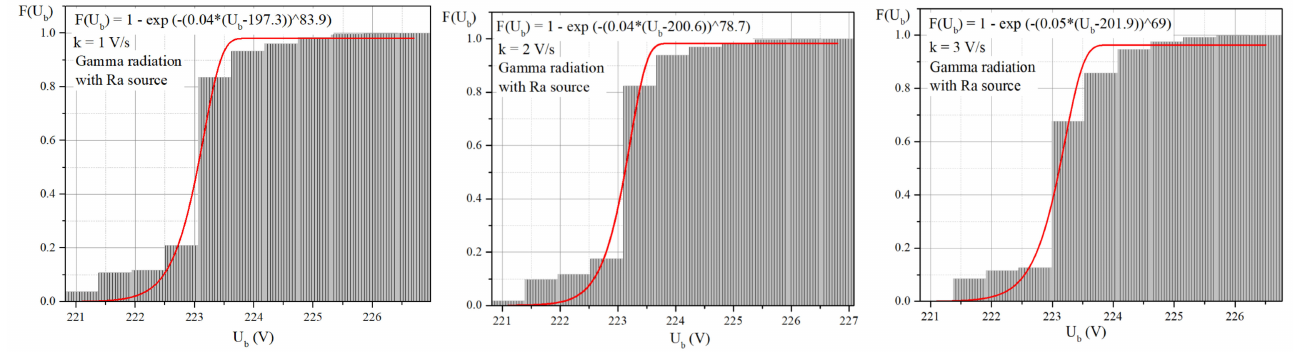
Figure 9. Cumulative distribution functions of CITEL GFSA in the presence of gamma radiation for increase voltage rates k = 1 V/s, k = 2 V/s, and k = 3 V/s,